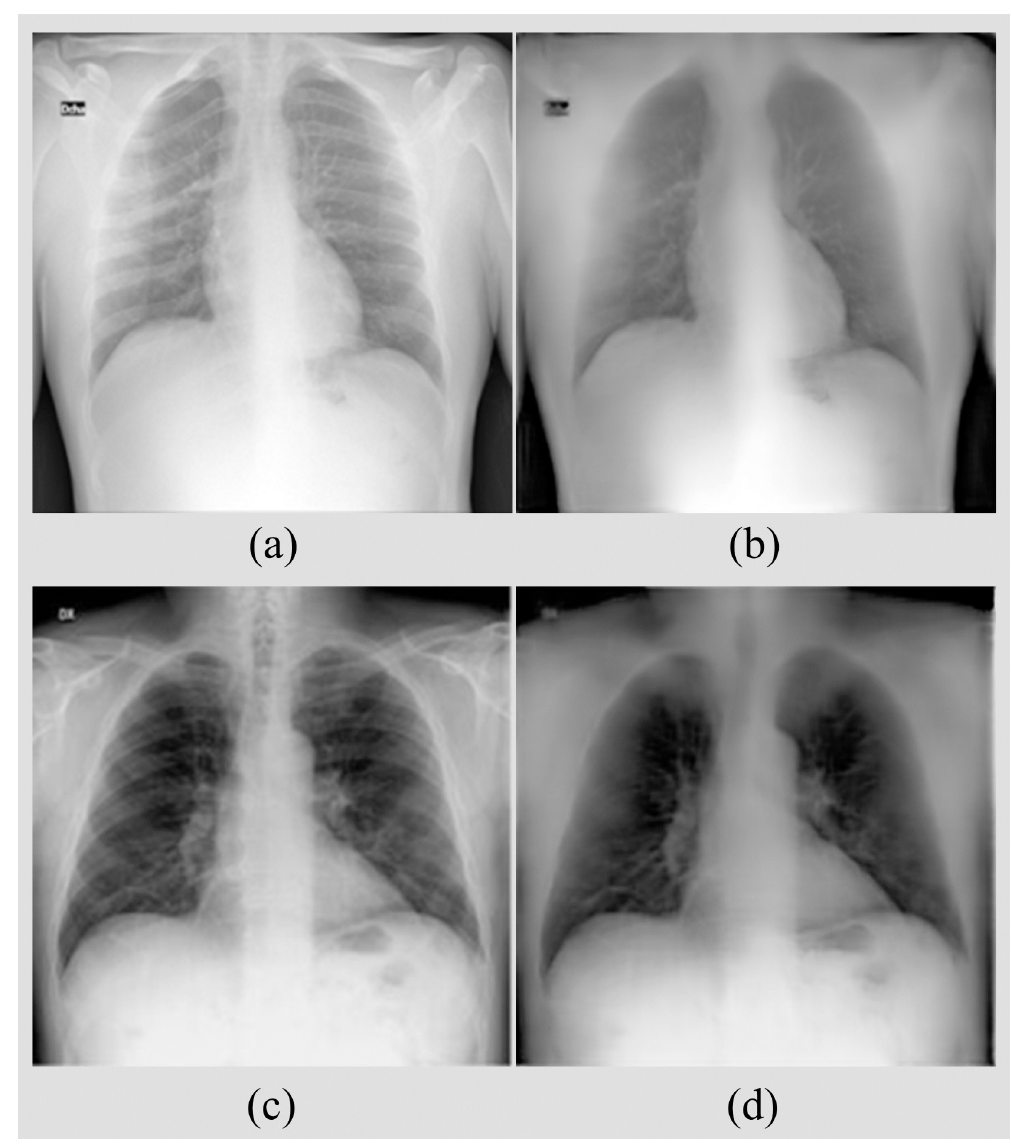
Fig 8. Bone-suppressed images predicted by the F-EB0-BS model using instances of CXRs with COVID-19-consistent findings. (a) CXR from the BIMCV-COVID19+ CXR data collection; (b) Corresponding bone-suppressed image; (c) CXR from the Twitter COVID-19 CXR collection, and (d) Corresponding bone-suppressed